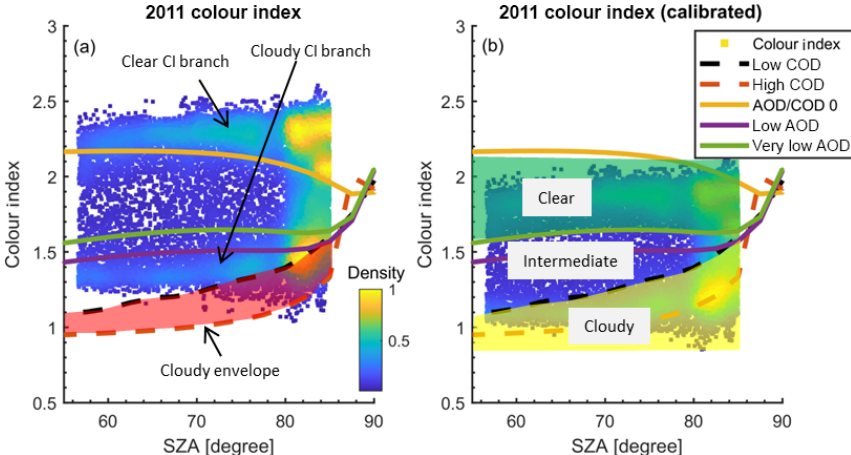
Figure 2. UT-GBS 2011 colour index before and after calibration, colour-coded by the normalized density of the points. Colour lines are SCIATRAN radiative transfer model CI results, with cloud optical depth (COD) and aerosol optical depth (AOD) conditions indicated in the legend. Panel (a) shows the measured CI and panel (b) shows the calibrated CI. Note that any measurements with solar zenith angle (SZA)>85 ◦ have been removed in this calibration process and are not shown